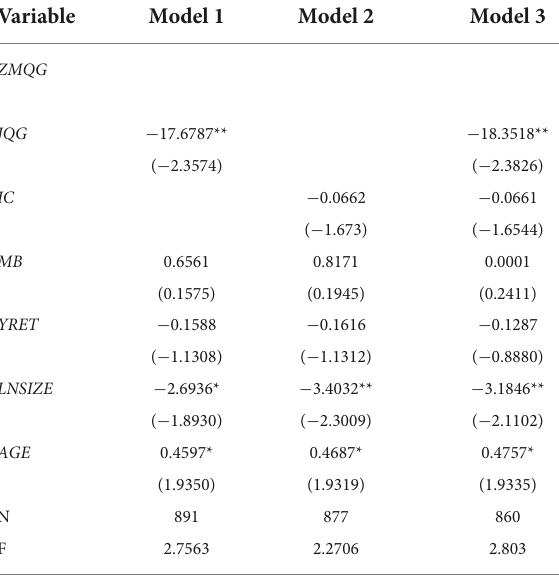
TABLE 7 Regression results of the moderating effect of earnings per share.